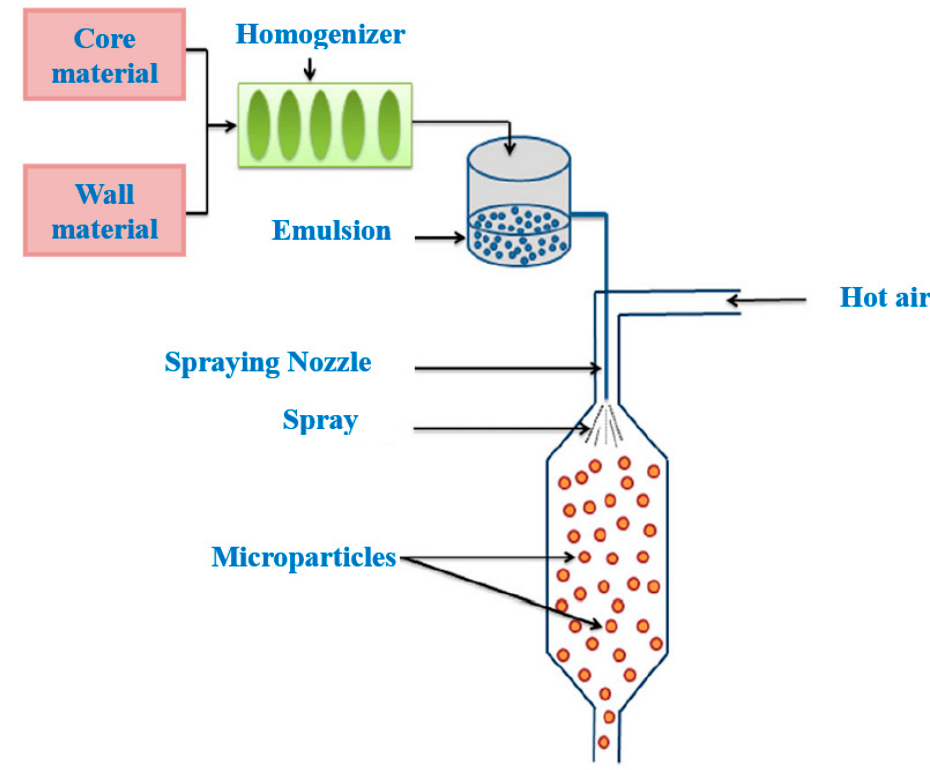
Figure 2. Microencapsulation process via spray drying (adapted from Barky et al., 2016 [41]). The selection